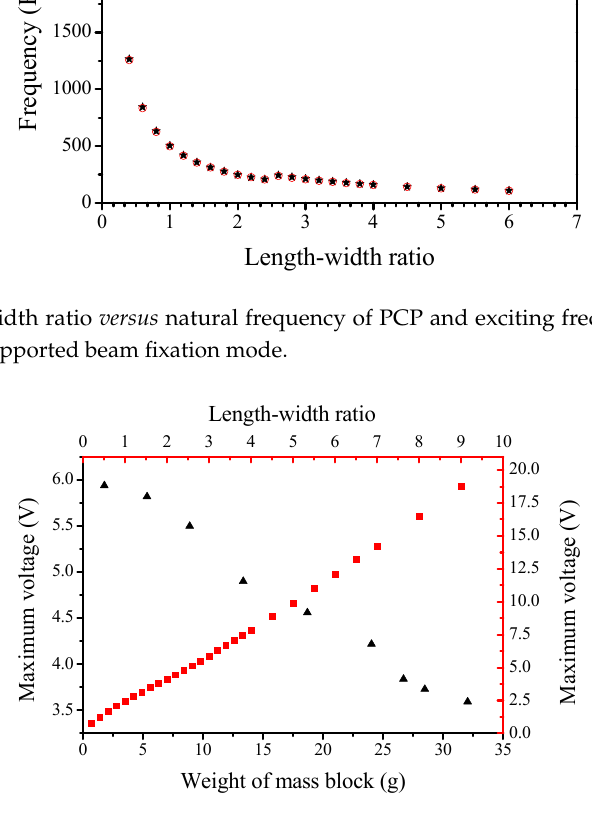
Figure 6. Weight of mass block and length ‐ width ratio versus maximum voltage in simply supported beam fixation mode.